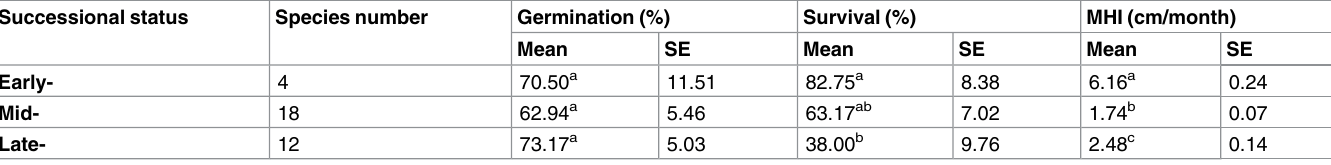
Table 4. Nurseryand field performanceof species from different successional stages. Successional